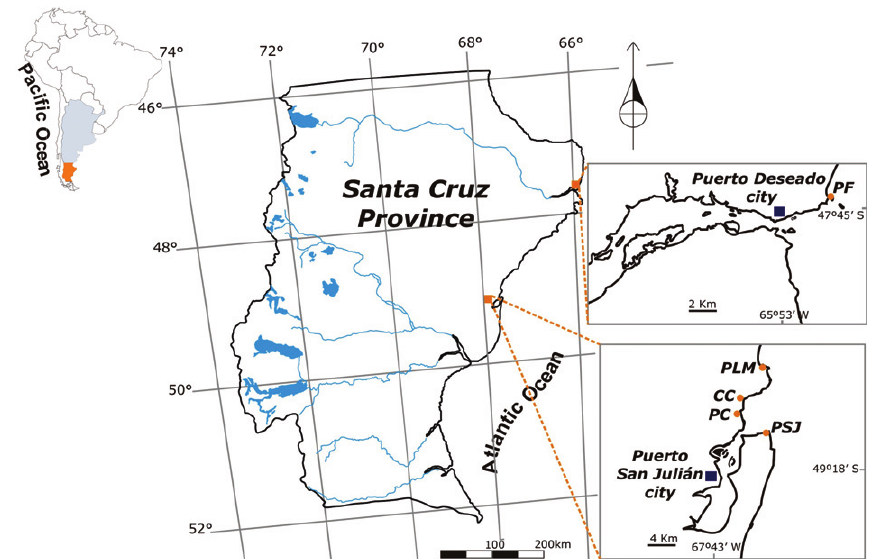
Figure 1. Sampling sites along the coast of Santa Cruz Province (Southern Patagonia, Argentina). Península Foca (PF), Punta Cueva (PC), Cabo Curioso (CC), Playa La Mina (PLM), Península San Julián